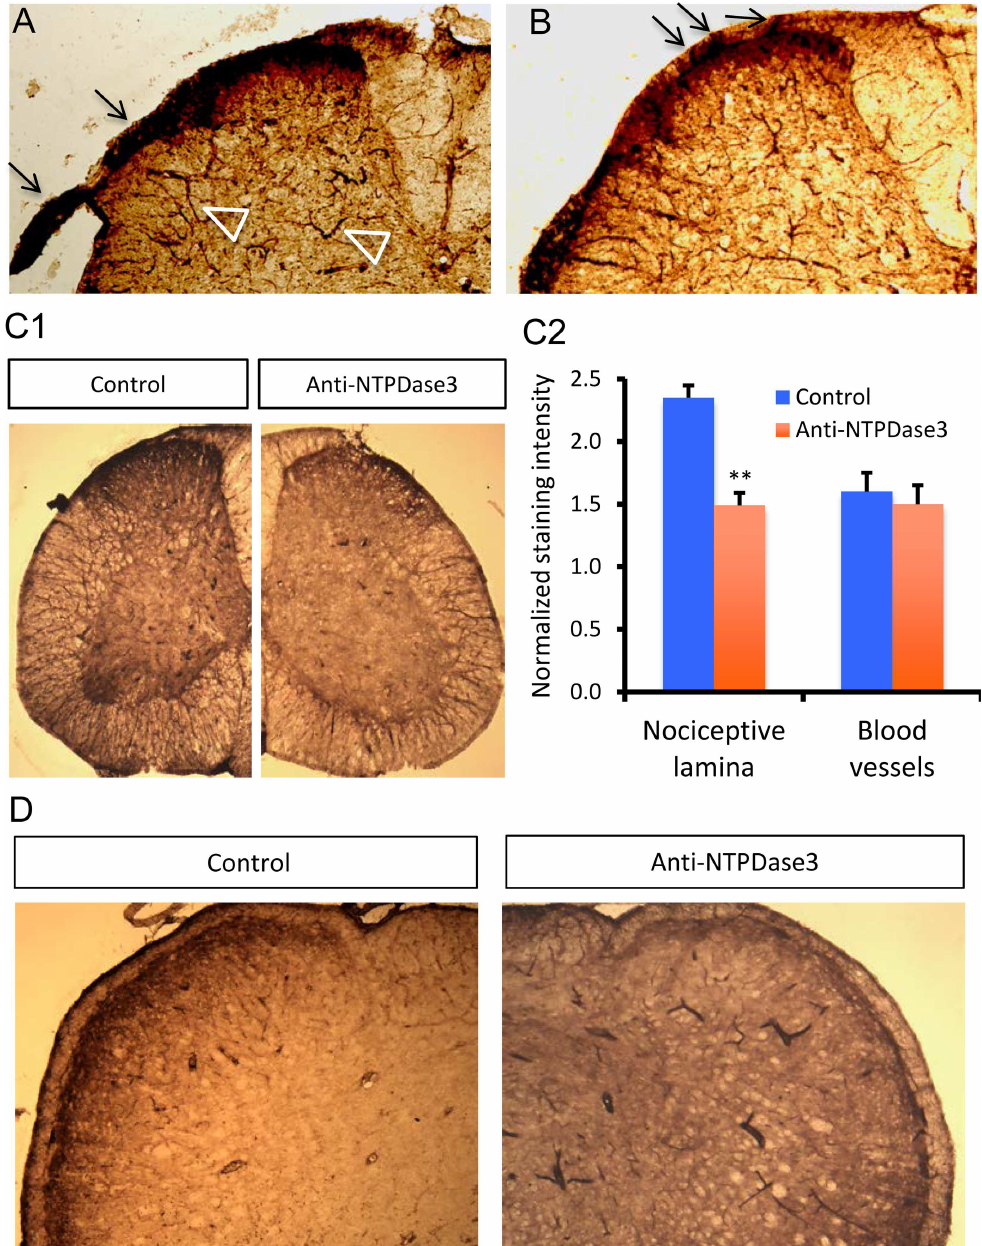
Fig 5. Ecto-NTPDase3 mediates ATP degradation in the nociceptive lamina of the spinal cord dorsal horn and trigeminal subnucleus caudalis. A: Enzymatic histochemistry detectionof ecto-ATPase activity in the spinal cord. Positive staining for ecto-ATPase activity is detected in dorsal root nerve (arrows) and in the outermost layer (nociceptive lamina) of the dorsal horn. Ecto-ATPase activity is also detected in large blood vessels (open triangles) in the spinal cord. B: Ecto-ATPase activity is detected in dorsal root nerve fibers that project to the nociceptivelamina of the dorsal horn. Arrows indicate the positive ecto-ATPase activity staining in dorsal root nerve fibers that penetrate the surface of the spinal cord and project to the nociceptivelamina of the dorsal horn. C: Pre-incubation with specific anti-NTPDase3 serum reduces ecto-ATPase activity staining in the spinalcord dorsal horn. C1: Ecto-ATPase activity staining in spinal cord sections incubated with either control serum (left) or anti-NTPDase3 serum (right). The intensity of ecto-ATPase activity staining in the dorsal horn nociceptive lamina is reducedafter incubationwith anti-NTPDase3 serum. C2: Changesof normalizedecto- ATPase activity staining intensity in sections after incubationwith either control or anti-NTPDase3 serum. The staining intensity for ecto-ATPase activity either in the dorsal horn nociceptive lamina or blood vessels